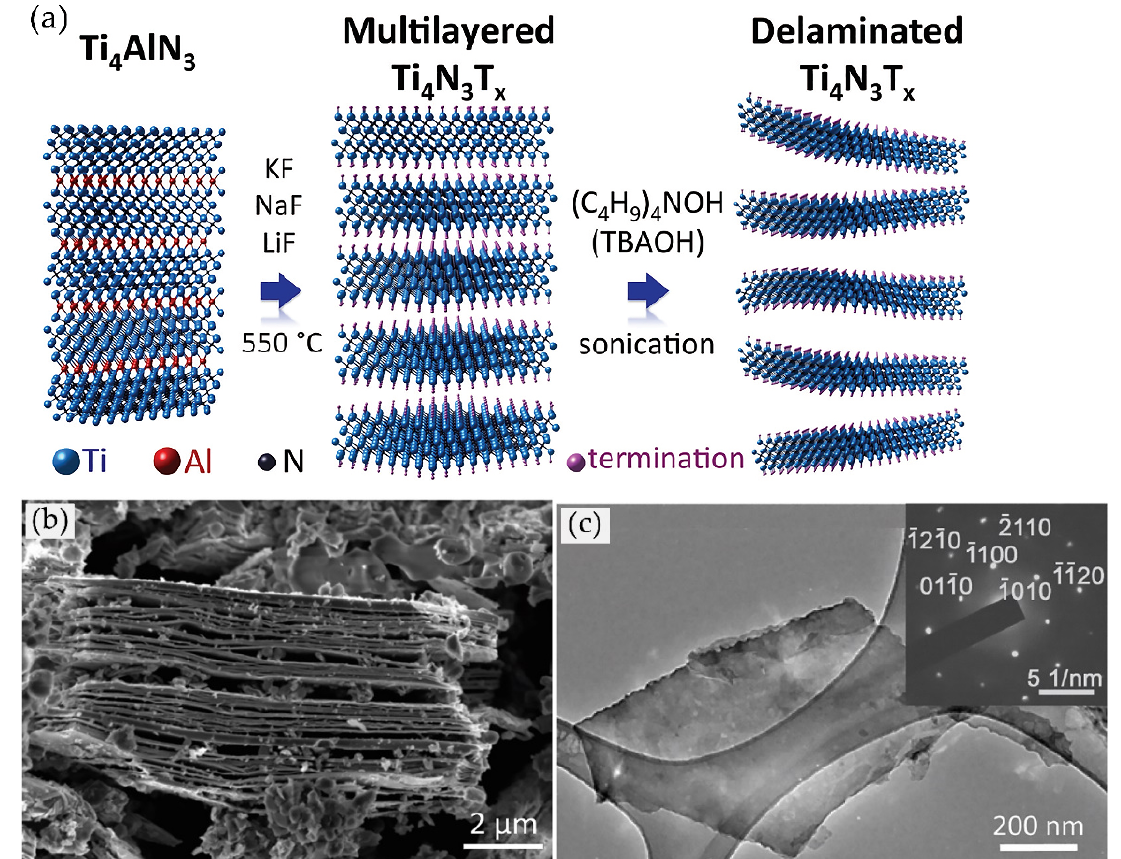
Figure 16. ( a ) Schematic representation of the process of obtaining the first nitride MXene by treatment of Ti 4 AlN 3 with a mixture of molten fluoride salts at 550 °C in Ar atmosphere, followed by delamination of multilayer Ti 4 N 3 T x using TBAOH. ( b ) SEM image of multilayer MXene after etching; and ( c ) TEM micrograph of a separate Ti 4 N 3 T x layer with electron diffraction from a selected region, which demonstrates the hexagonal symmetry of the basal plane. Reprinted with permission from [75] 2016 RSC Pub.